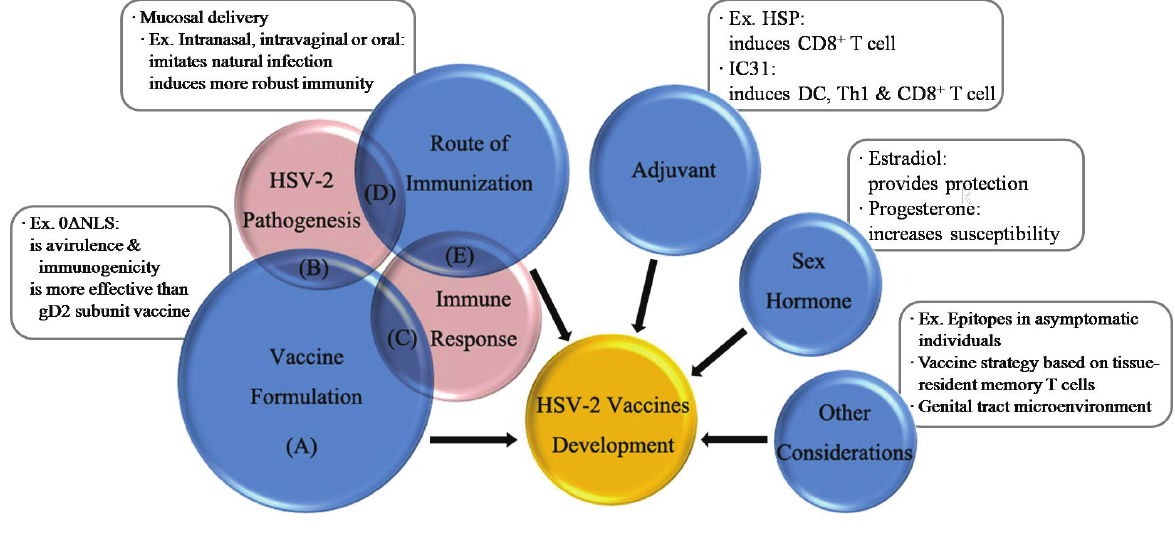
Figure 2. Factors of developing an effective vaccine. ( A ) The size of the circle